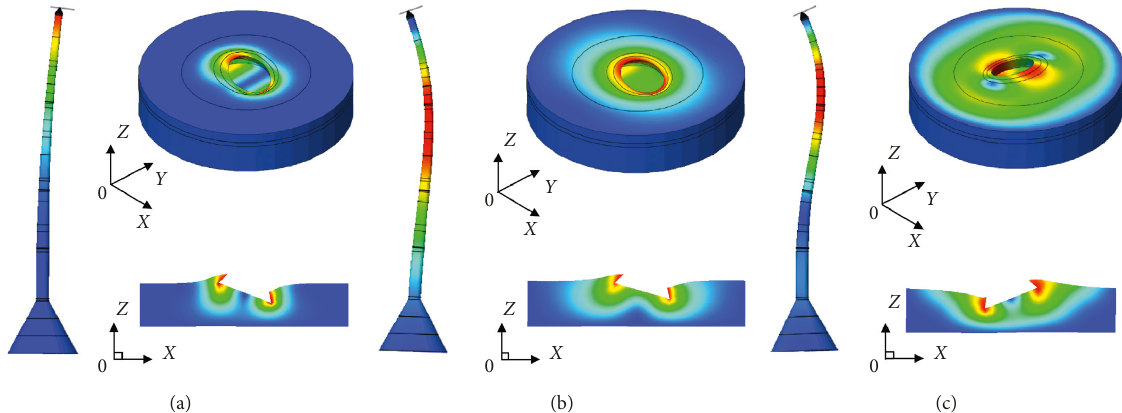
Figure 3: Along-wave directional bending modes from eigenvalue analysis. (a) Mode Bx1 (0.2830Hz). (b) Mode Bx2 (1.5619Hz). (c) Mode Bx3 (2.4006 Hz).